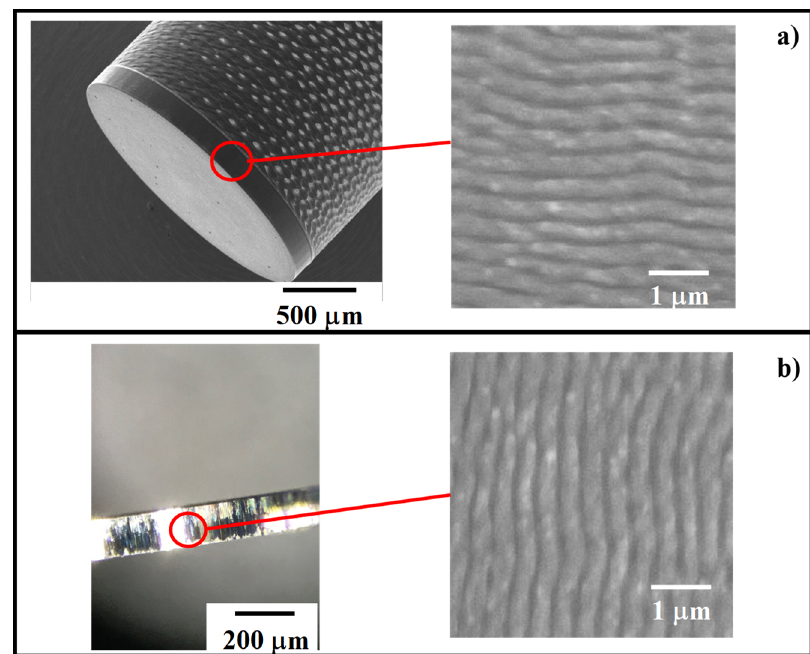
Figure 1. Manufacturing concept of the simultaneous nano-texturing with laser trimming process and of the concurrent formation of nanotextures with fine piercing. ( a ) Simultaneous nanotexturing in the axial direction on the punch side surface with femtosecond laser trimming and ( b ) the concurrent formation of nanotextures on the hole surface along the piercing direction with fine piercing of a metallic sheet.